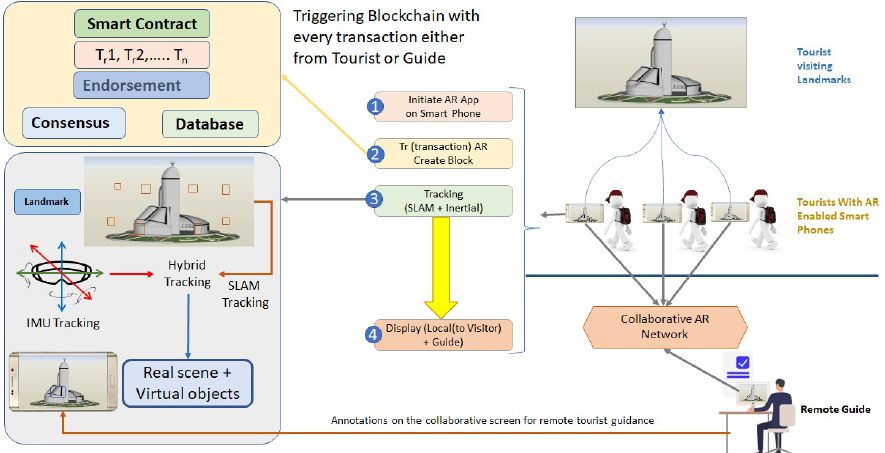
Figure 12. Sharing of the real-time environment of CAR tourist app for multiple users